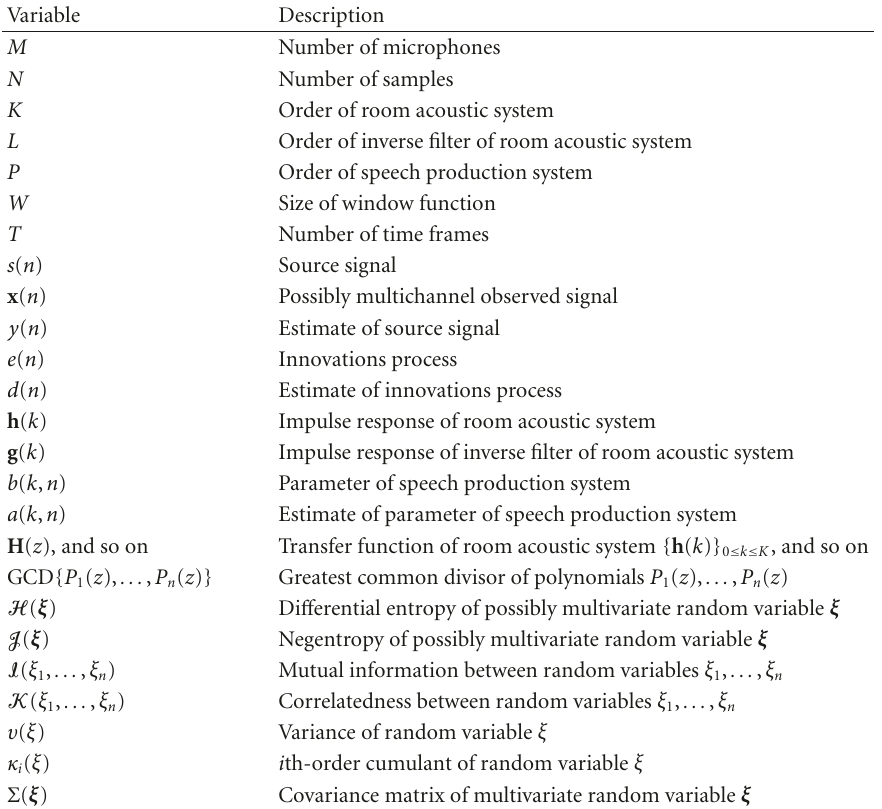
Table 1: List of main